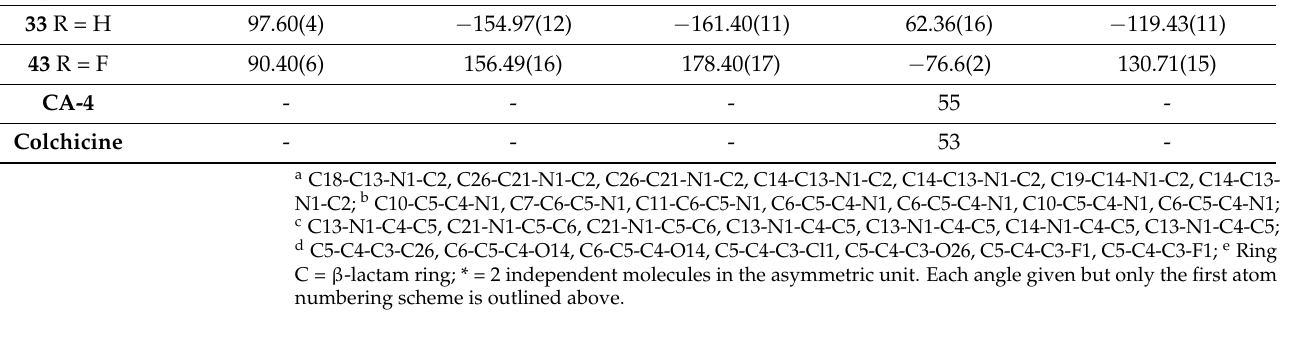
C = β -lactam ring; * = 2 independent molecules in the asymmetric unit. Each angle given but only the first atom numbering scheme is outlined